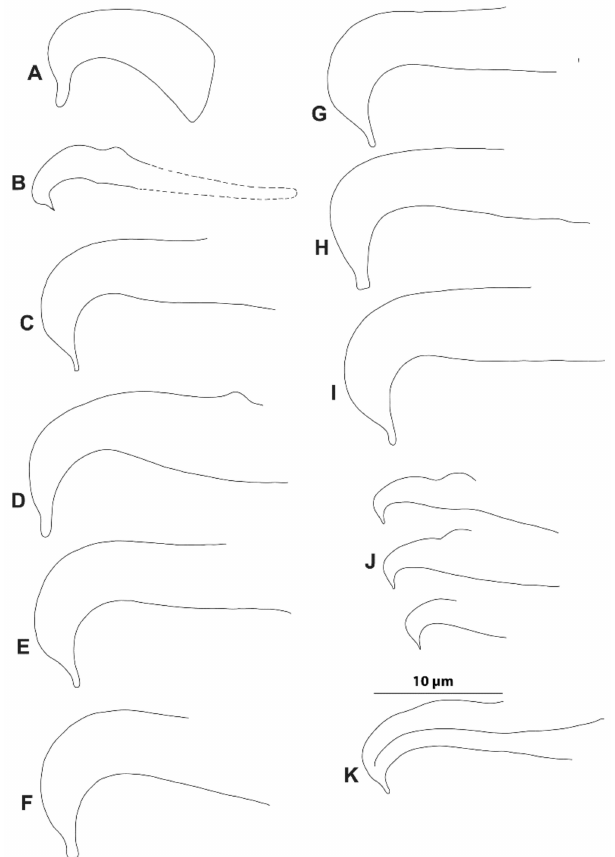
O. punicae (Figure 8; Table S5a) , O. mangiferus (Figure 9; Table S5b) and O. vitis (Figure 10; Table S5c) from various geographical locations [3–5,7,9,10,12–14,17–19,25,40,42,45,51–53] and considered variations in the present study.